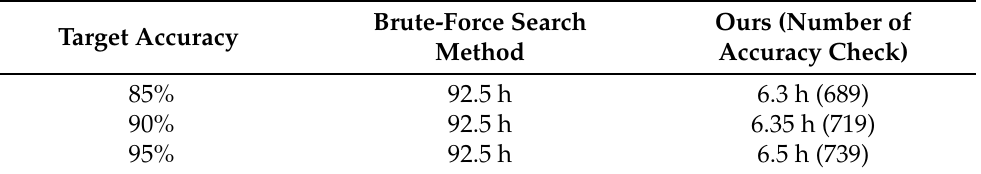
Table 11. The execution times in the corresponding accuracies derived from the proposed method and the individual cases of network slimming and deep compression for DenseNet